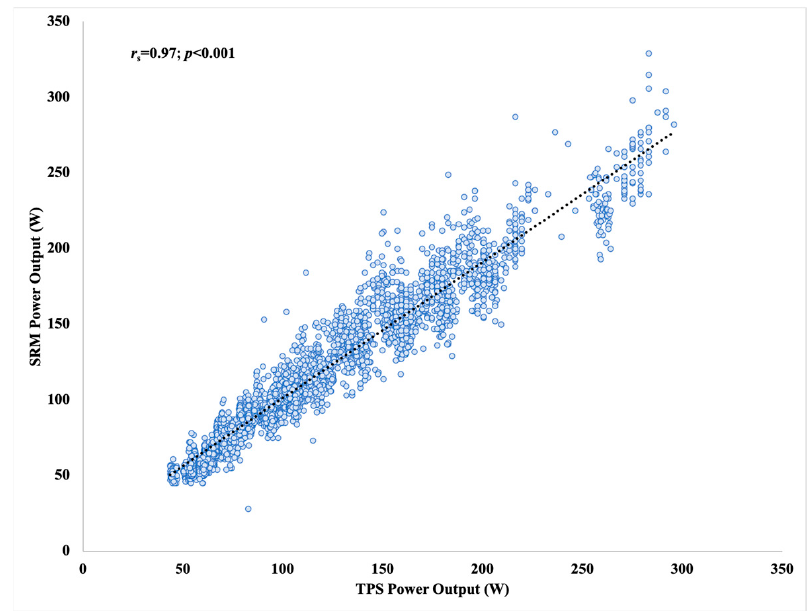
Figure 2. Correlation results of 1 S raw data between devices.